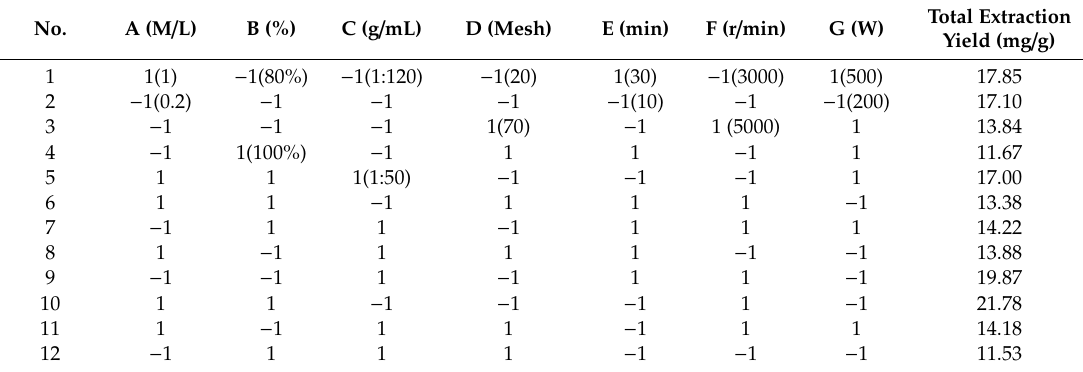
Table 1. Factors (in coded levels) of the Plackett–Burman (PB) design with total extraction yield (mg / g) as a response.